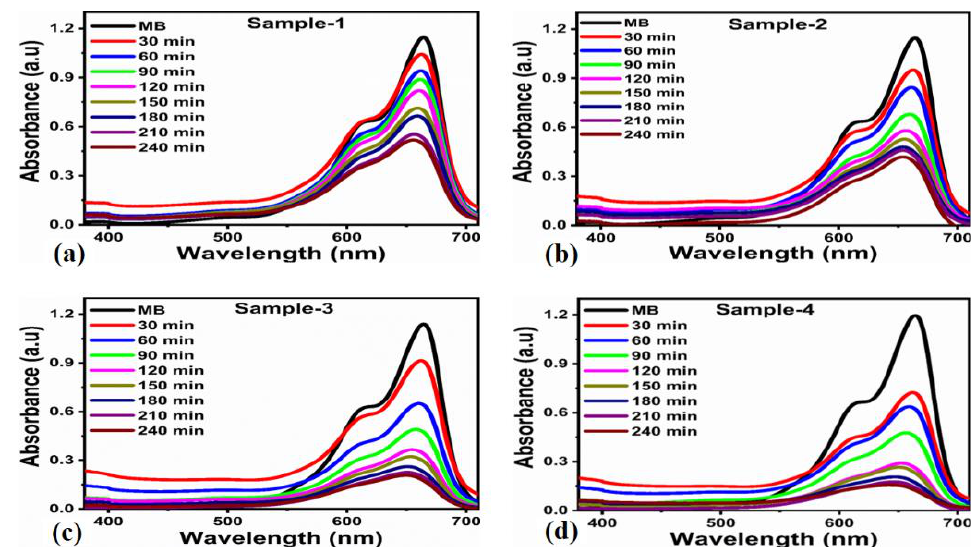
Figure 5. ( a – d ) UV-Vis absorption spectra of the MB solution at concentration of 1.87 × 10 −5 M, using 5 mg photocatalyst dose of hybrid materials during photodegradation under UV light illumination, using samples 1 – 4 as photocatalysts.